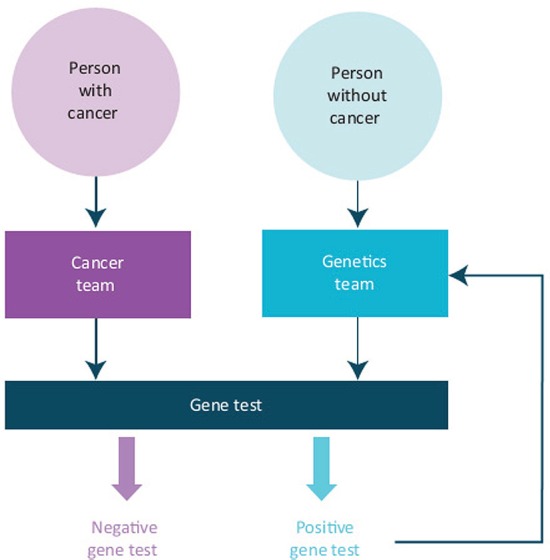
Proposed new pathways to deliver cancer predisposition gene testing. (With thanks to Prof N. Rahman [11].)